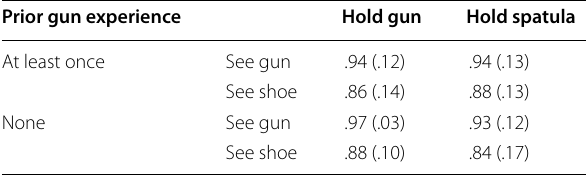
RTs (and between-subject standard deviations) in ms for Experiment 2 Prior gun experience Hold gun Hold spatula At least once